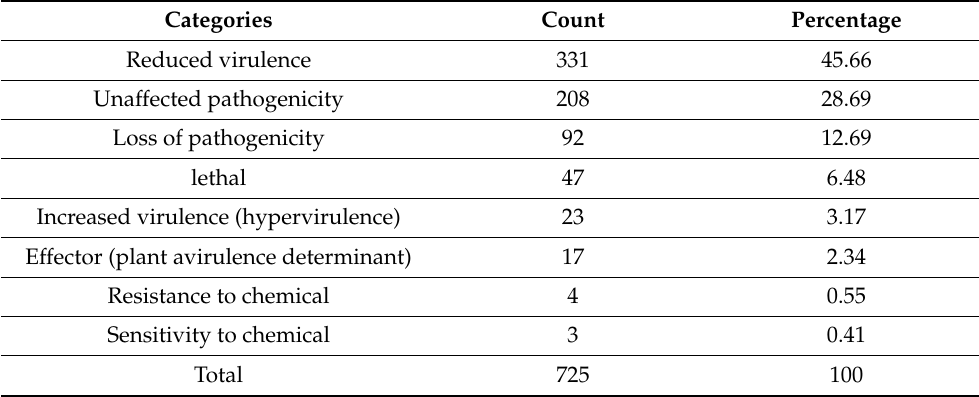
Table 3. PHIBase analysis of DEGs identified in response to fungus infection in lentil.